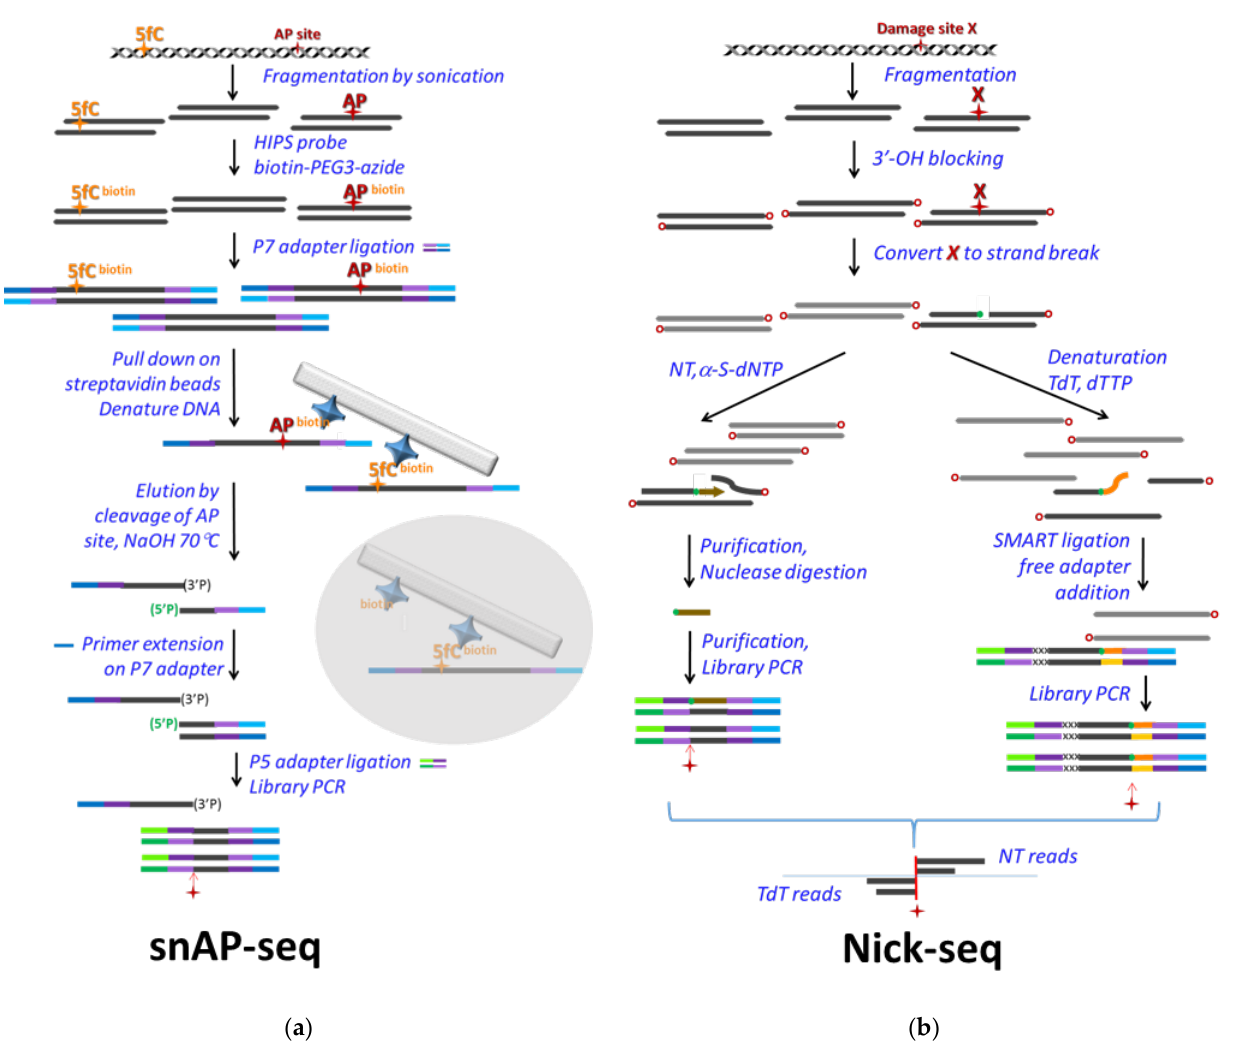
Figure 4. ( a ) snAP-seq. Genomic DNA fragments are chemically labelled by an aldehyde-reactive HIPS probe [116], either at the AP sites (red star) or at formylcytidine (yellow “5fC”) or formyluridine. The HIPS probe is labelled by biotin via a PEG3 linker (biotin – PEG3 – azide) which allows efficient pull-down of the P7 adapter ligated and labelled fragments on streptavidin beads (grey rectangle represents the solid phase, blue star: streptavidin tetramers). After denaturation of the dsDNA bound on the beads, AP site fragments are selectively eluted by alkaline cleavage, when only one of the DNA strands downstream from the AP site will be appropriate for ligation. Upon primer extension from the P7 adapter, the resulted dsDNA will also be ligated to the P5 sequencing adapter. The PCR amplified library is sequenced, where the first base of the P5 reads will report on the AP sites (red star). ( b ) Nick-seq. First, 3′ -OH groups are blocked by dideoxy nucleotide addition (red “o”) to the fragmented genomic DNA. Then, damage sites (red “X”) are converted to ssDNA breaks with free 3′ -OH (green dot). Further processing is performed parallelly in two portions of the sample. NT: nick translation by polymerase I using α -thio-deoxynucleoside triphosphates ( α -S-NTP) precursors that will result in phosphorothioate oligonucleotides resistant for nuclease treatment. These purified fragments are used for sequencing adapter ligation, library PCR and sequencing. TdT: terminal transferase is used to tail the free 3′ -OH with poly(dT) using the commercially available SMARTER Chip-seq kit (Clontech). Addition of the sequencing adapters then depends on the poly(dT) tail, and applies a template-switching polymerase reaction instead of ligation, ensuring higher specificity of the library preparation. The sequencing results from NT and TdT processing are compared, and reads are positioned next to the damage site downstream and upstream, respectively.